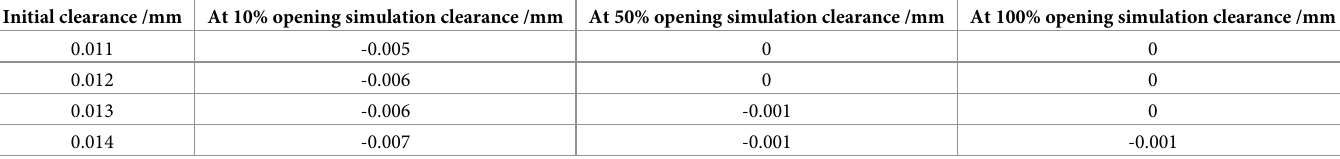
Table 3. The simulation clearances at different openings when different initial clearances are